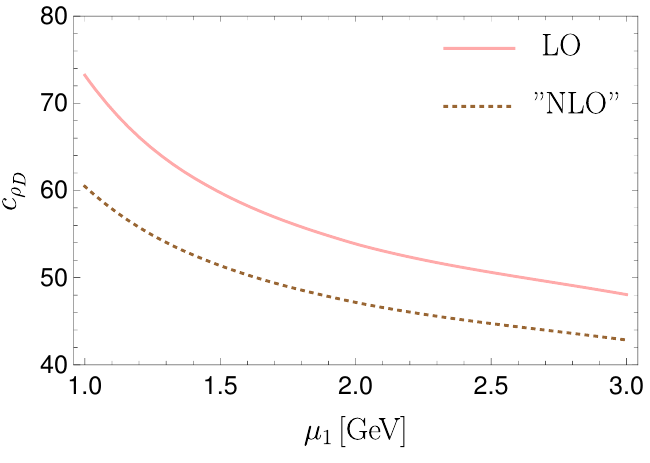
Figure 4 . Scale dependence of the coefficient of the Darwin operator.